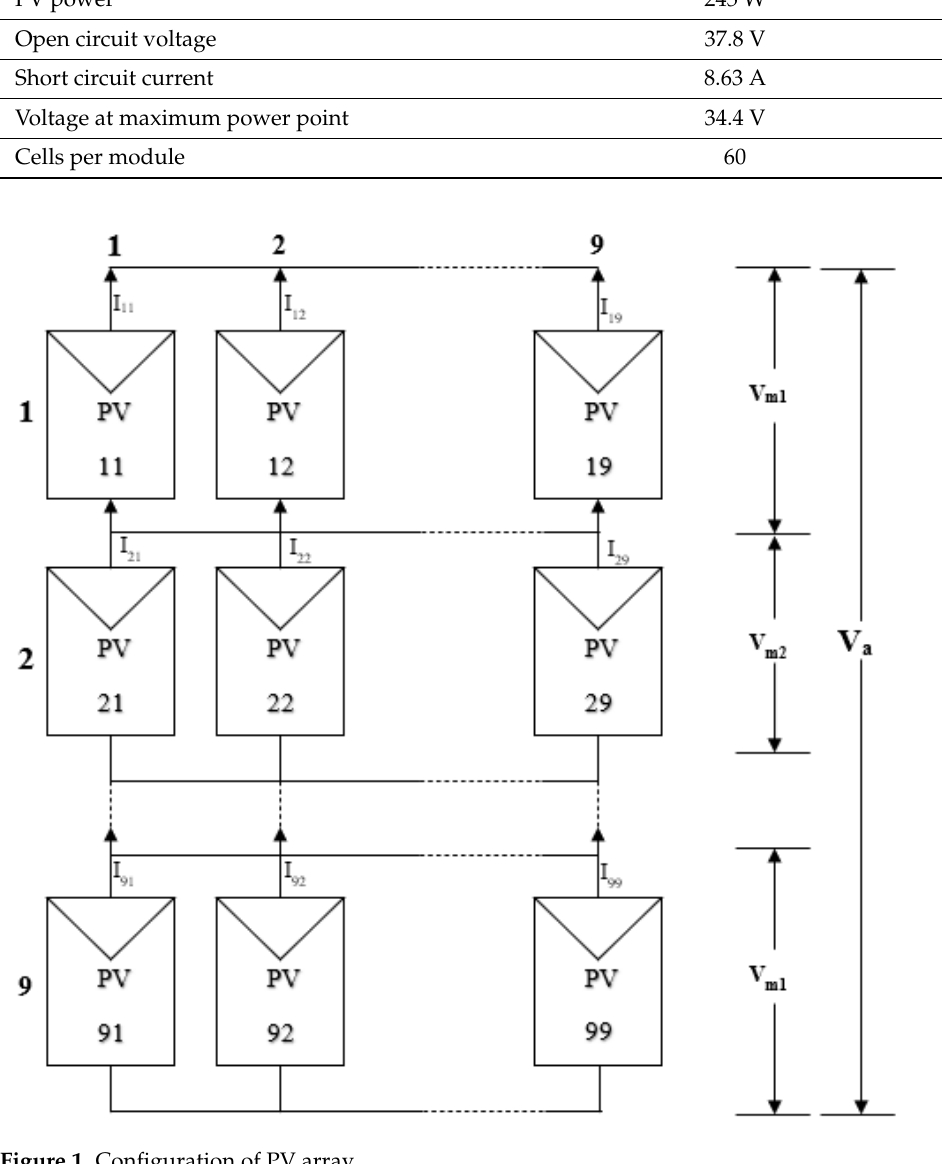
Table 1. Specifications for YL245P-29b PV module at standard test conditions.